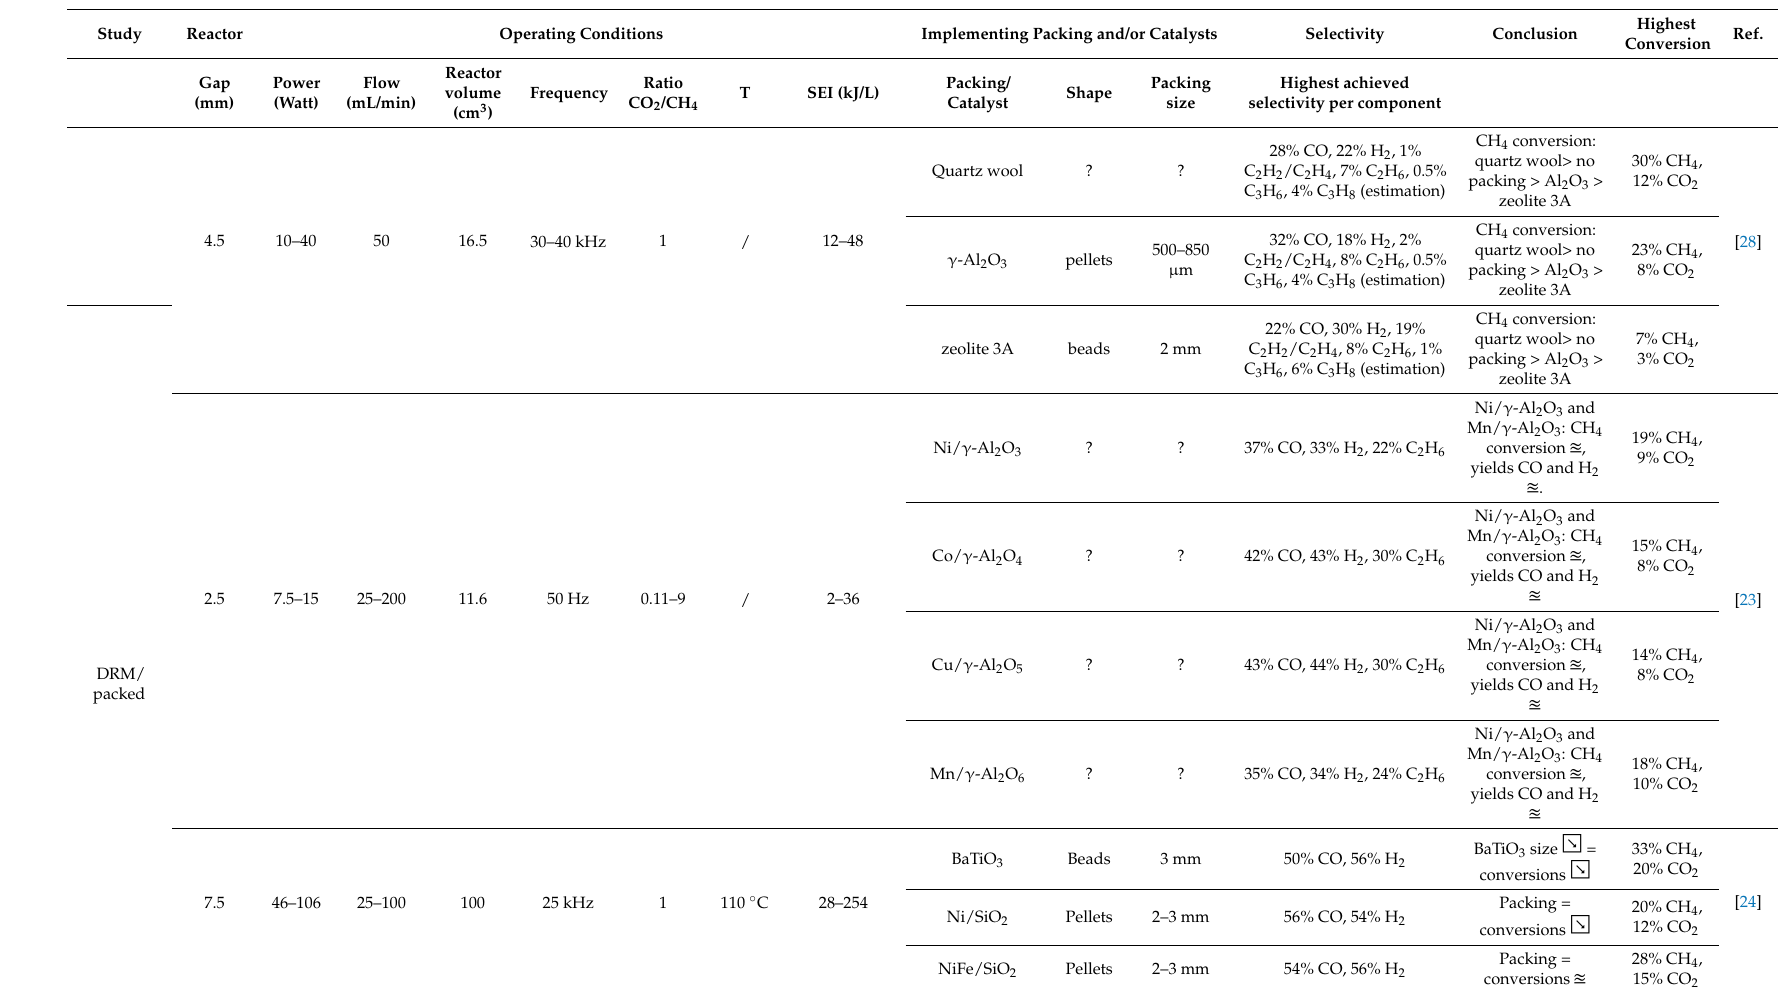
Implementing Packing and/or Catalysts Selectivity Conclusion Packing size